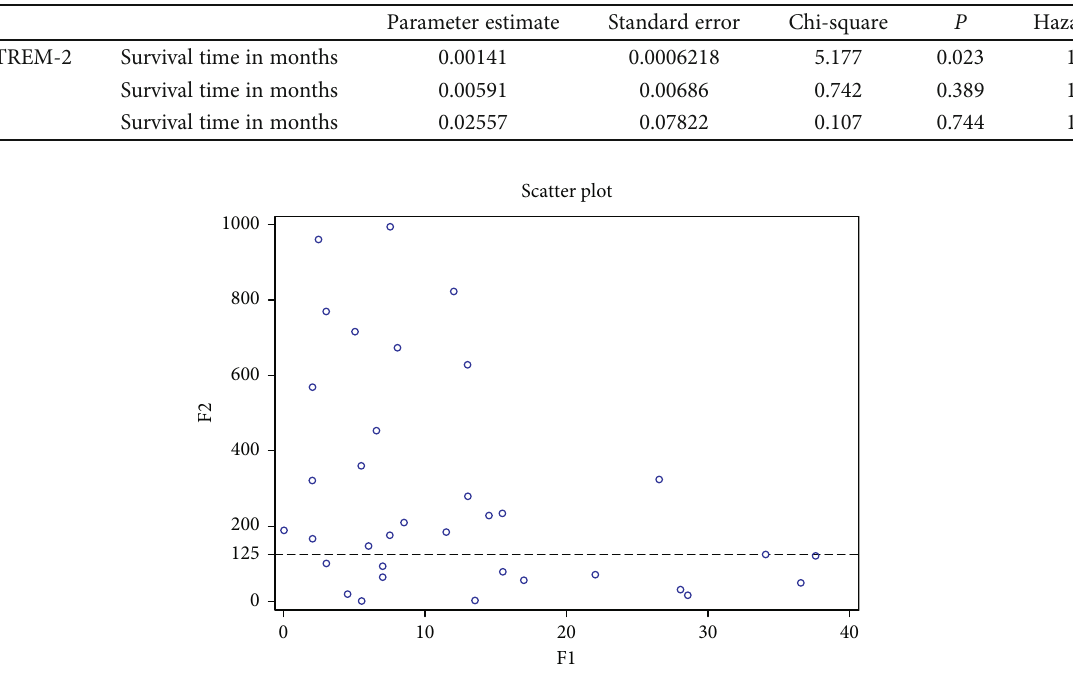
Figure 1: Scatter plot of correlation between survival time and TREM-1/TREM-2 ratio in grades III and IV ( N = 37 ). F1: survival time in months; F2: TREM-1/TREM-2